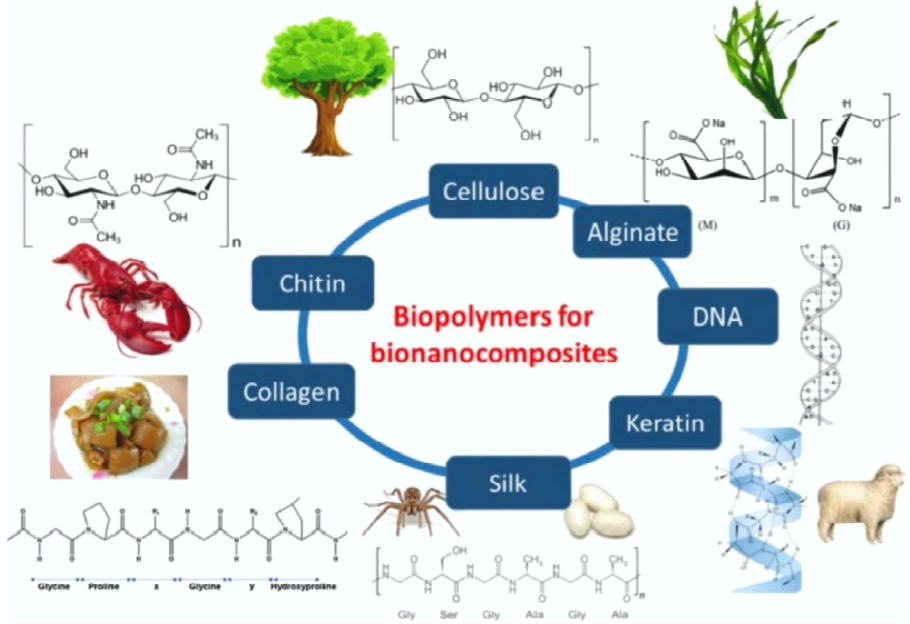
Figure 7. Different biopolymers that allow the development of bio-nanocomposites [39].